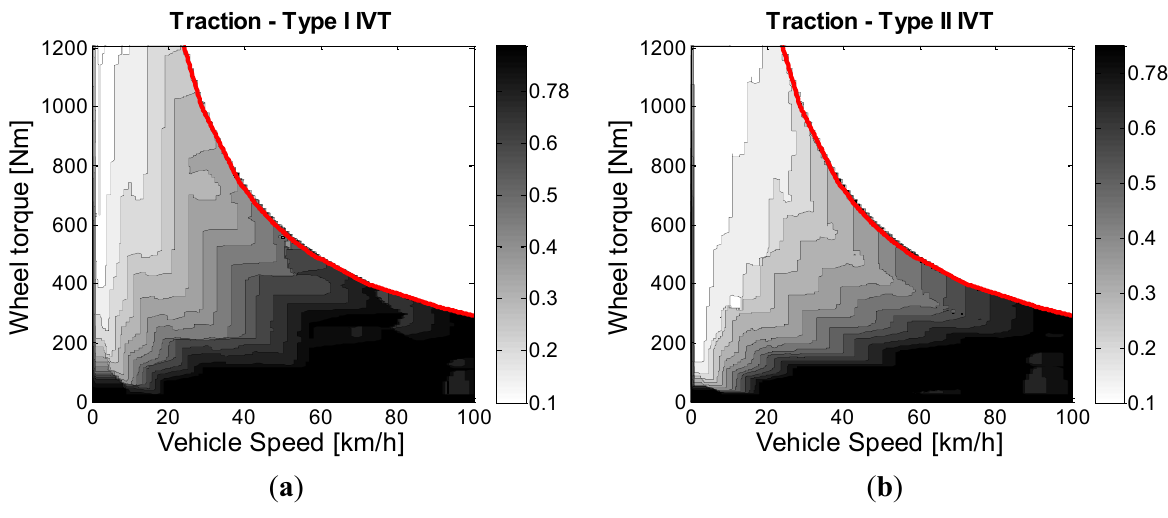
Figure 11. Traction driving chart for ( a ) Type I IVT and ( b ) Type II IVT.